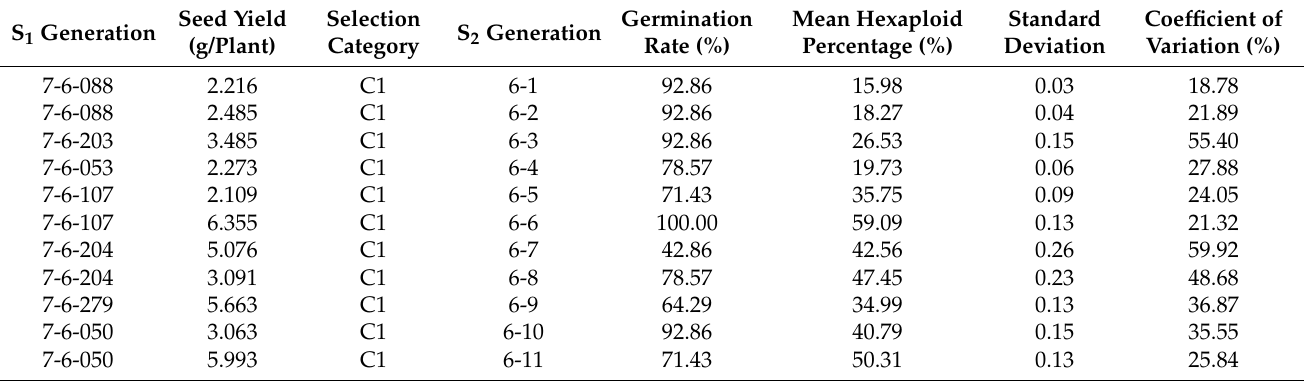
Table 1. The classification, germination rate and ploidy level estimation of S 2 generation derived from an allohexaploid Brassica hybrid